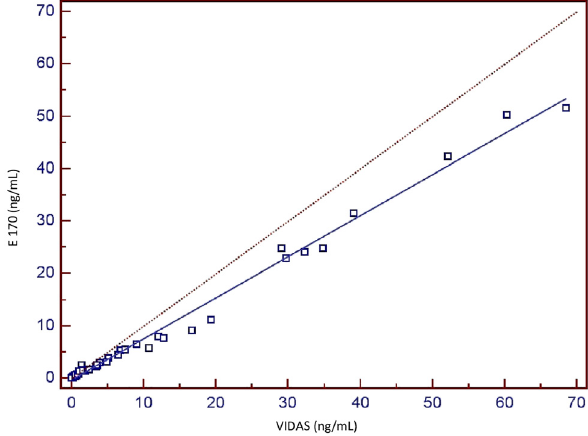
Figure 2: Deming regression analyse of E170 and VIDAS measurement results. Deming regression equation was found y=0.78x − 0.26 (Sy/x=1.14).